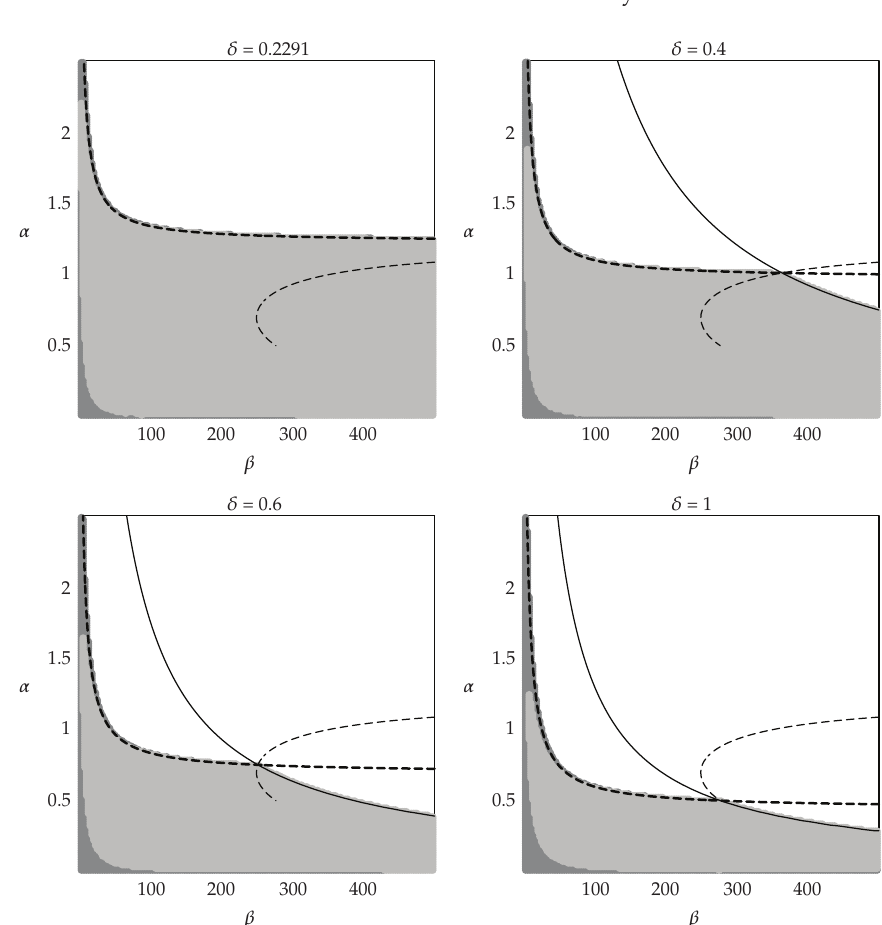
Figure 2: The region of stability of equilibrium in the (cid:4) β,α (cid:7) plane for γ (cid:9) 1 . 2 and sample values of δ.